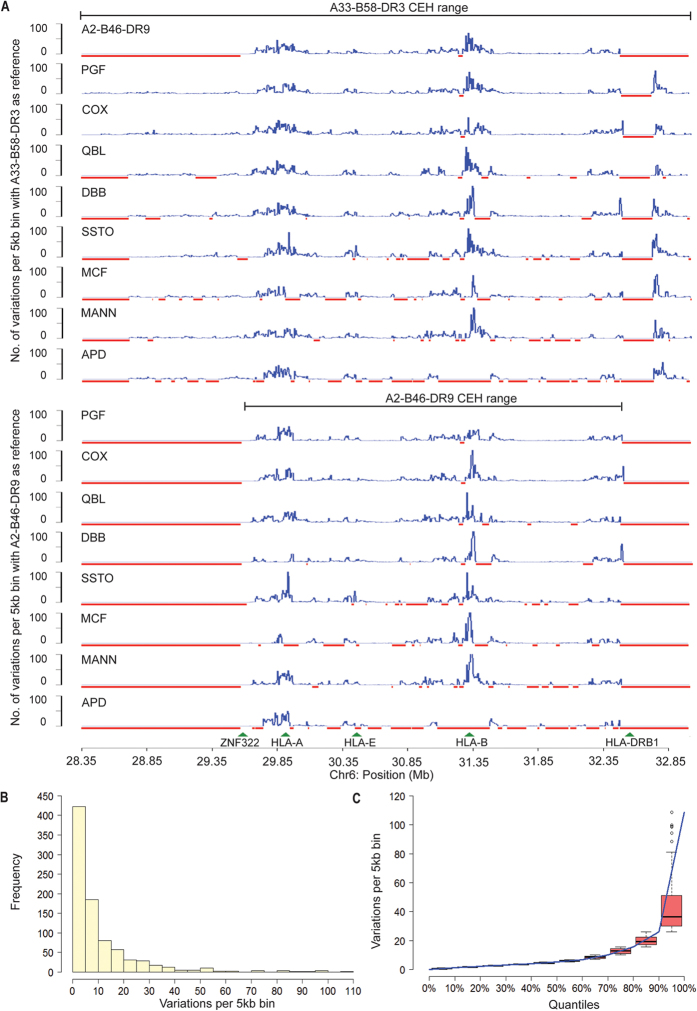
Pairwise inter-haplotypic variation across the MHC region.(A) A33-B58-DR3 and A2-B46-DR9 haplotype sequences were compared with each of the eight common European-descent MHC haplotypes (PGF, COX, QBL, DBB, SSTO, MCF, MANN, APD). The variation counts were binned into non-overlapping 5-kb windows. The red bars indicate gaps in the sequence of the haplotypes. (B) Frequency histogram of the number of variations for each 5-kb window. (C) Cumulative distribution for the number of variations per 5-kb bin across each 10% quantile interval.